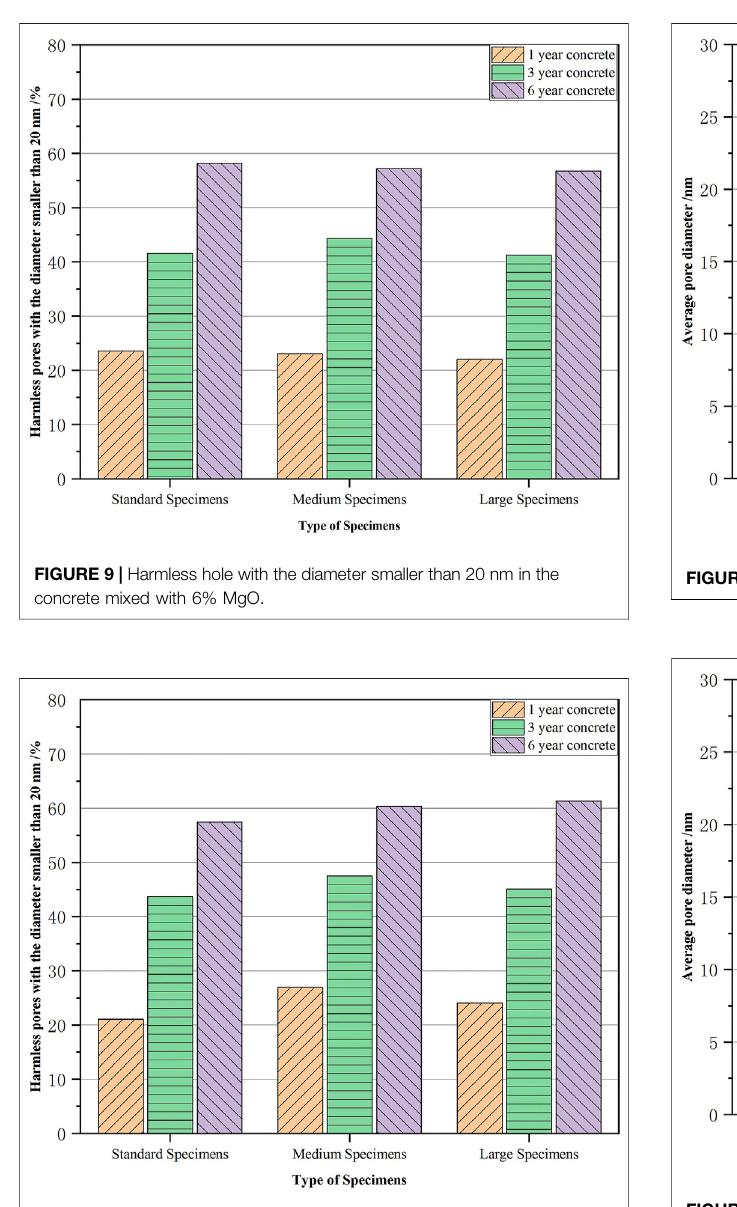
FIGURE 12 | Average pore size of concrete mixed with 10%